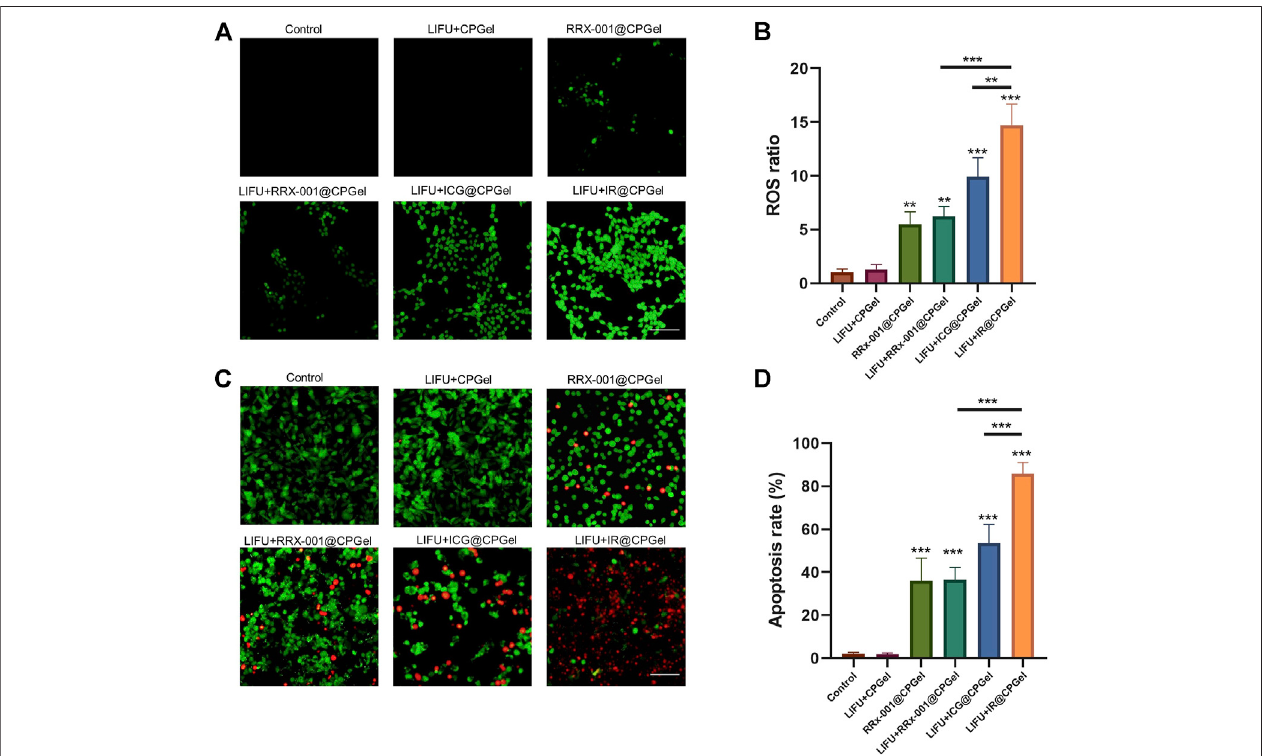
FIGURE2| Invitro antitumor ef fi cacyofIR@CPGel. (A) ROSlevelinducedbydifferentformulationsinMDA-MB-231cells;scalebar=100 µm (B) Semiquantitative analysis of ROS levels from different treatment groups; (C) Calcein-AM/PI staining of MDA-MB-231 cells treated with different formulations; scale bar = 100 µm (D) Semiquantitative analysisofapoptosisrateinMDA-MB-231cellstreatedwithdifferentformulations.Alldataareshownasthemean±SD.(n=3), pp p < 0.01and ppp p < 0.001 vs.